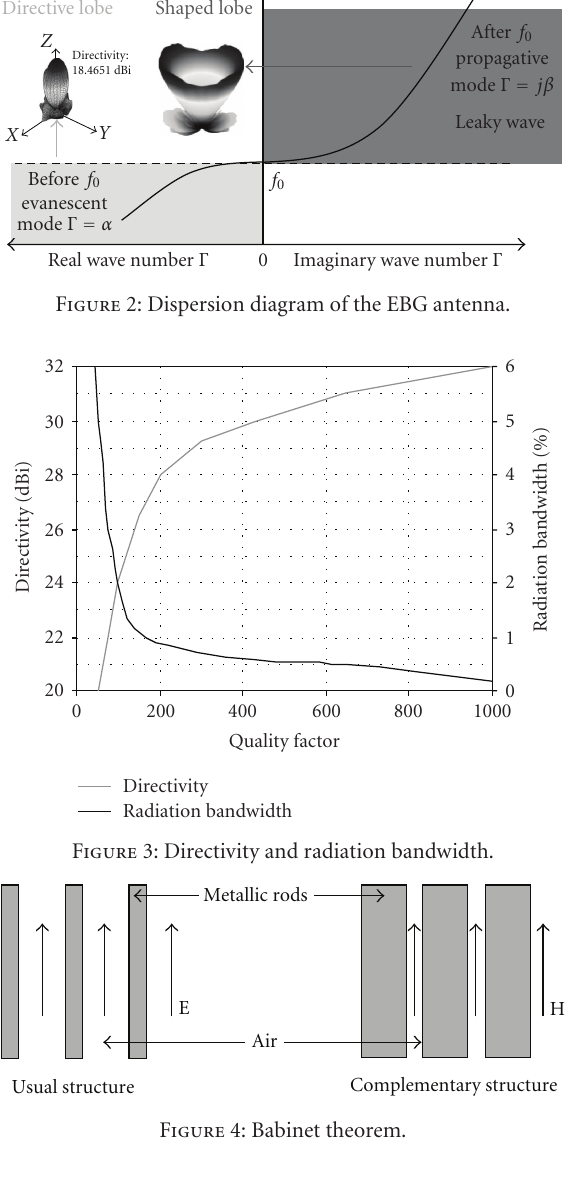
Figure 4: Babinet theorem.